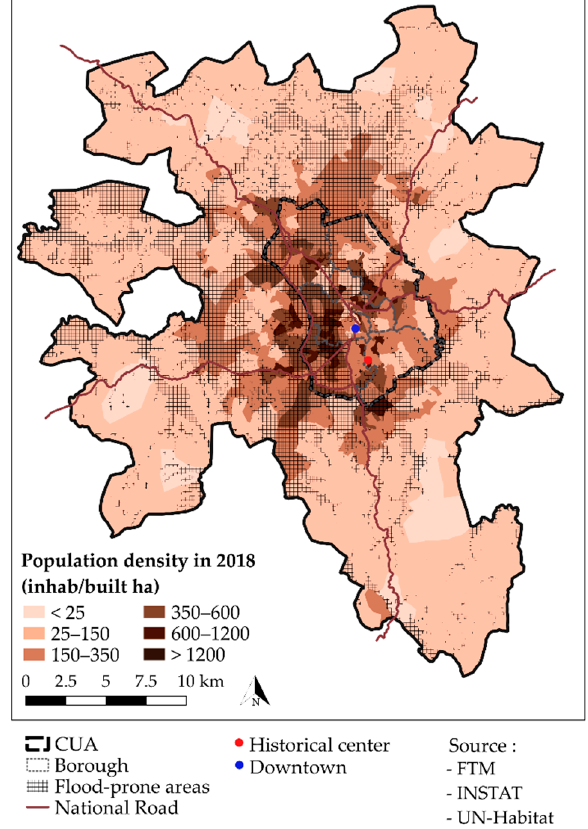
Figure 7. Residential population density in 2018.